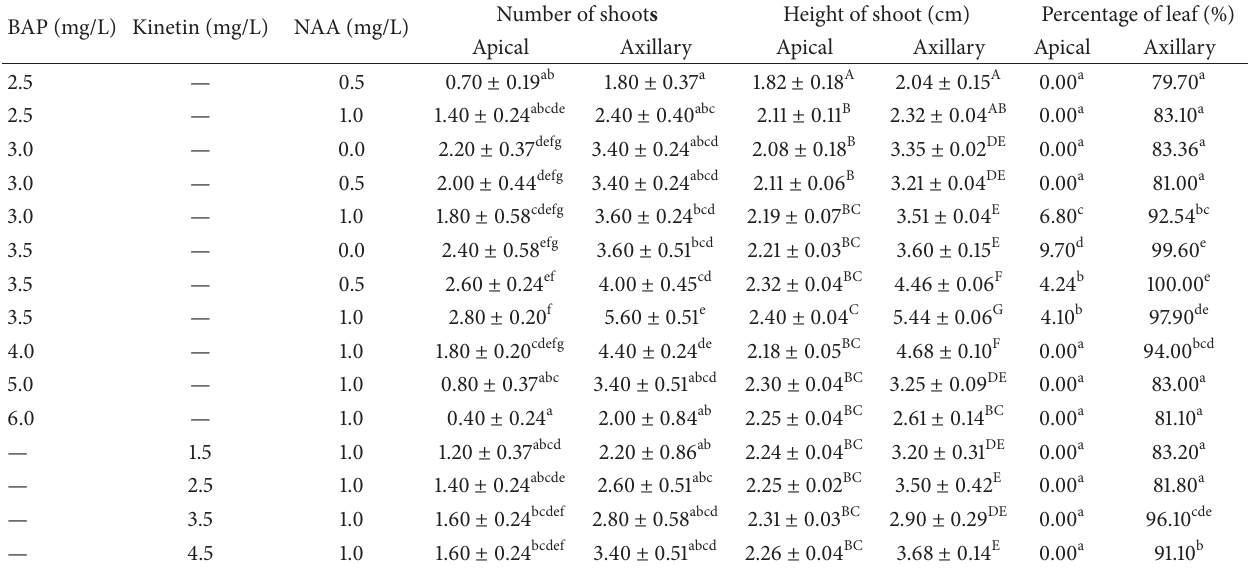
Table 3: Effects of different concentrations and combinations of cytokinin and auxin on shoot production from two different sources of explants in yellow C. Crotalifera